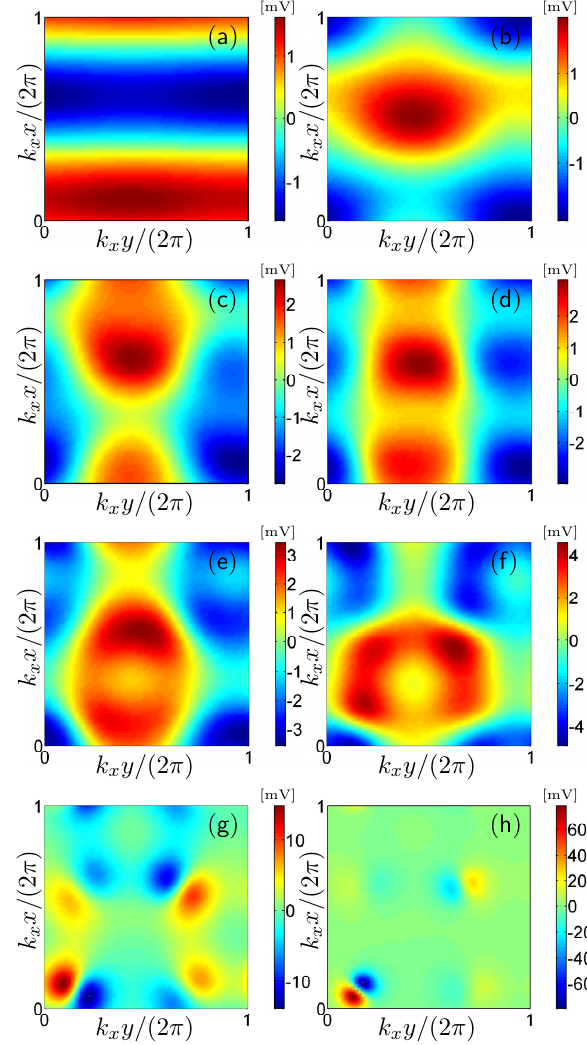
Fig. 2. Panels (a–h) show Re (φ L ) in a plane perpendicular to B 0 at t = 0 . 51, 0.61, 0.67, 0.69, 0.70, 0.71, 0.72, and 0.73s,